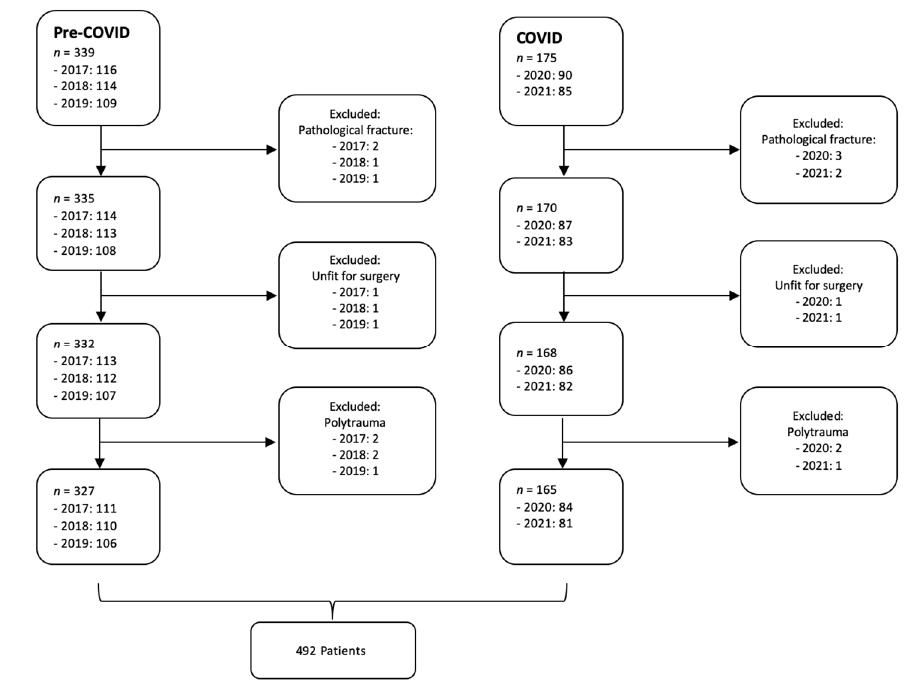
Figure 1. Study flow diagram. Table 1. Epidemiological data—surgical and fracture characteristics.